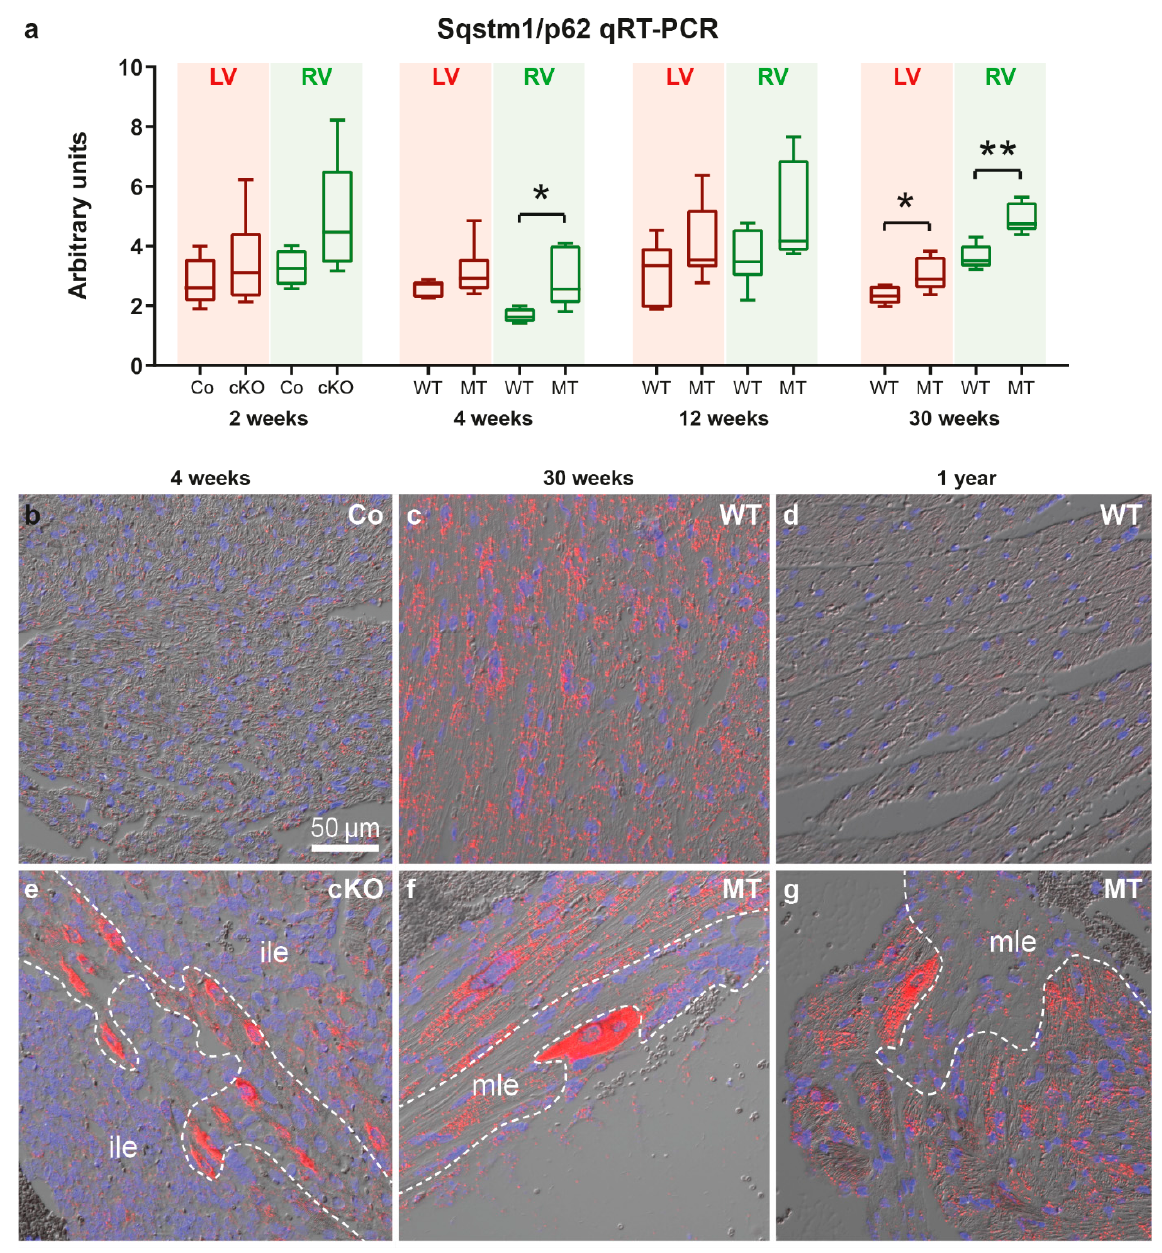
Figure 3. Sqstm1/p62 mRNA expression is elevated at disease onset and during chronic disease progression in Dsg2 -mutant hearts. ( a ) The Tukey’s whisker plots depict p62 mRNA expression determined by qRT-PCR in the right ventricle (RV) and left ventricle (LV) of Dsg2 cKO (cKO) and homozygous Dsg2 flox(E4 − 5) control (Co) mice aged 2 weeks (prior to macroscopic lesion formation) as well as Dsg2 MT (MT) and wild-type (WT) mice at the indicated time points of the acute and chronic disease phase. The non-parametric Mann-Whitney test was applied (* p ≤ 0.05; ** p ≤ 0.01). Further details of the statistical evaluation are provided Supplemental Tables S1 and S2. ( b – g ) show representative results of Sqstm1/p62 mRNA in situ hybridization. ( b – e , g ) show left ventricles, ( g ) depicts a right ventricle. Red dots indicate the presence of Sqstm1/p62 mRNA. The red channel is merged with the corresponding differential interference contrast image and nuclear Hoechst 33,342 detection (blue). Note the increased Sqstm1/p62 mRNA expression in cardiomyocytes located next to immature myocardial lesions (ile, ( e )) and matured fibrotic lesions (mle, ( f , g )), which is in agreement with the SQSTM1/p62 immunodetection in Figure 2. Positive and negative control experiments are shown in Figures S6–S8. Scale bar: 50 µm in b (same magnification in all images).